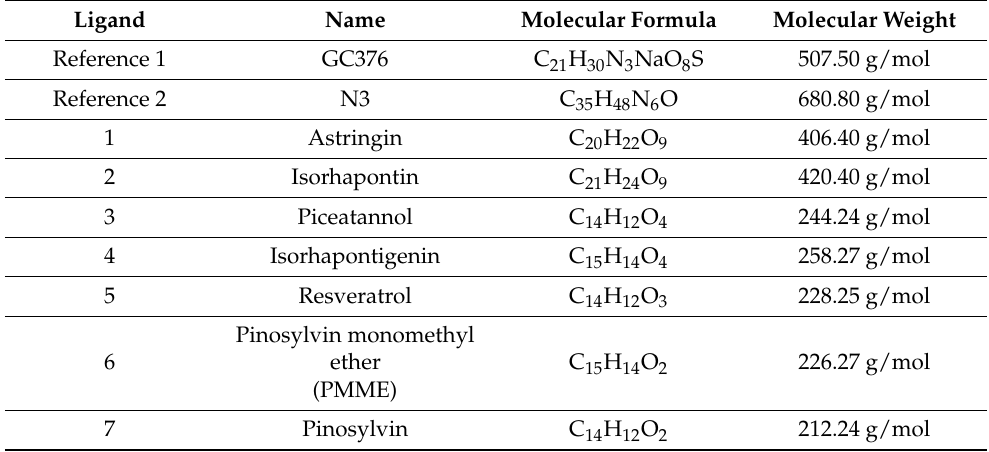
Table 1. Reference and stilbene compounds used for the molecular docking studies against M pro